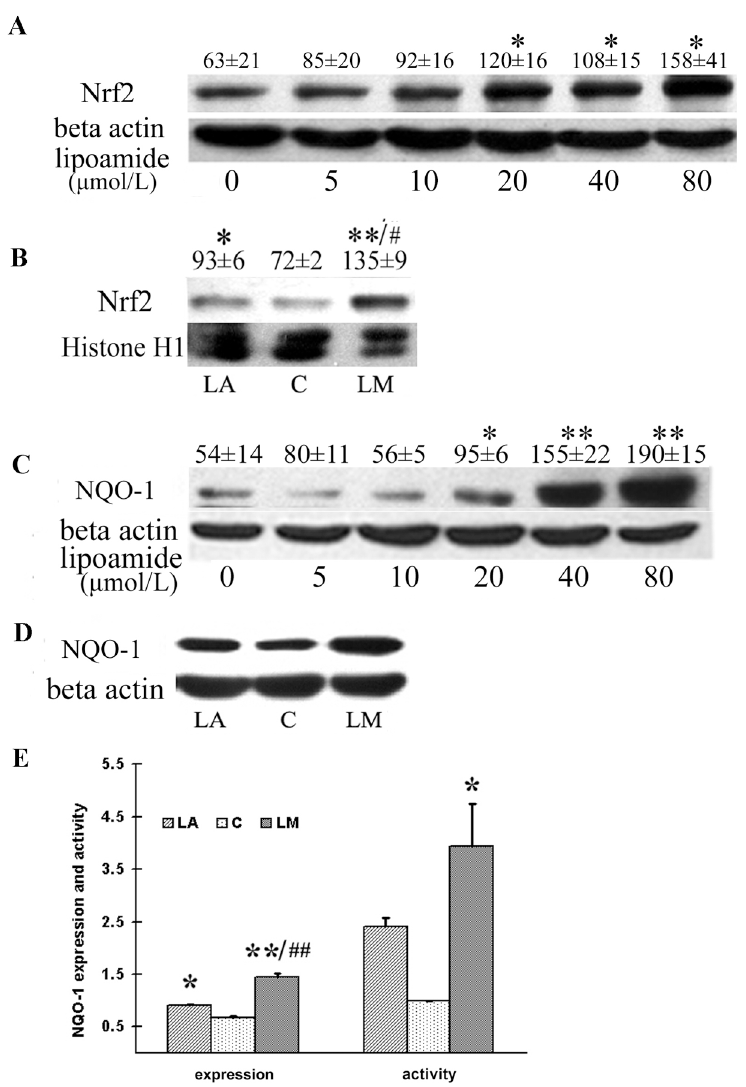
Fig 4. LM treatment increased Nrf2 expression in both total and nuclear protein fraction, and increased expression and activity of NQO-1. ARPE-19 cells were treated with the indicated concentrations of LM for 48 h, or 40 μ mol/L of LA or LM if concentrations not indicated. (A) A representative image of Nrf2 expression in total protein detected by western blot. Optical densities were analyzed with Quantity One software, and results are expressed as ratios of Nrf2 to β -actin in arbitrary units. (B) A representative image of Nrf2 expression in nuclear protein. Quantitative analysis of Nrf2 expression in nuclear protein was quantified in the same way as for Nrf2 expression in total protein. (C) A representative image of NQO-1 expression detected by western blot. Quantitative analysis of NQO-1 expression in total protein was performed in the same wa with Nrf2.. (D) A representative image of NQO-1 expression. (E) Quantitative analysis of NQO-1 expression and activity. All values are means ± SEM of four independent experiments. Statistical significance was established by one way ANOVA followed by the Tukey test. * p < 0.05, and ** p < 0.01 vs. control, and # p < 0.05, ## p < 0.01 vs. LA